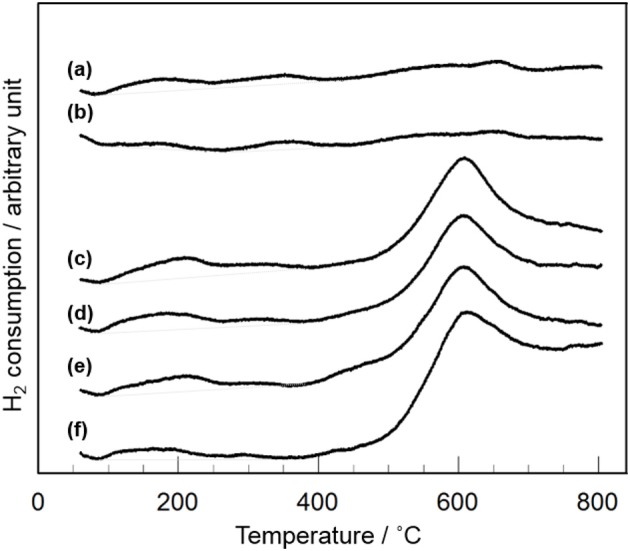
H2-TPR profiles of CeO2(x)/Y2O3(CP) with different CeO2 loading. (a) Y2O3, (b) CeO2(1)/Y2O3(CP), (c) CeO2(3)/Y2O3(CP), (d) CeO2(4)/Y2O3(CP), (e) CeO2(5)/Y2O3(CP), (f) CeO2(10)/Y2O3(CP).